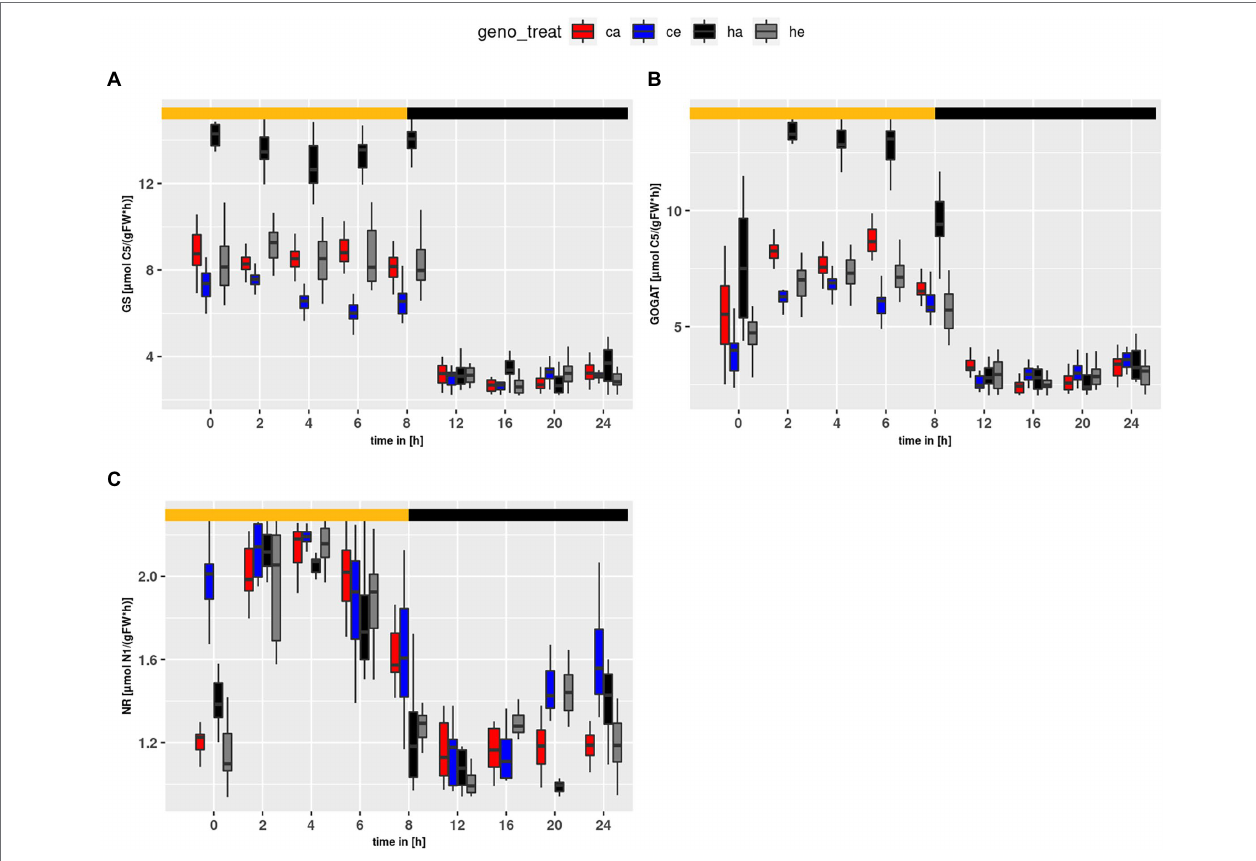
FIGURE 7 | Diurnal course of fluxes for (A) GS, (B) GOGAT and (C) NR. Col-0 ambient: red, Col-0 eCO 2 : blue; hpr1-1 mutant ambient: black, hpr1-1 mutant eCO 2 : grey. Shown are means of results for 20 simulations. Light phase is indicated by yellow bar and dark phase indicated by black bar. Boxplots are dodged by 0.25 h in order to prevent